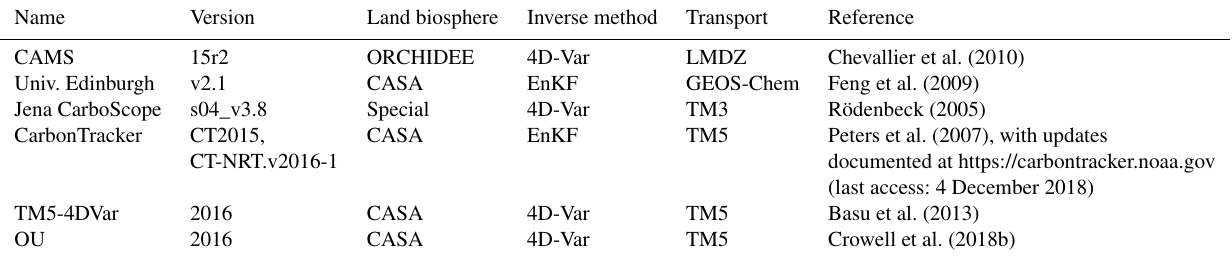
Table 8. Models used in this